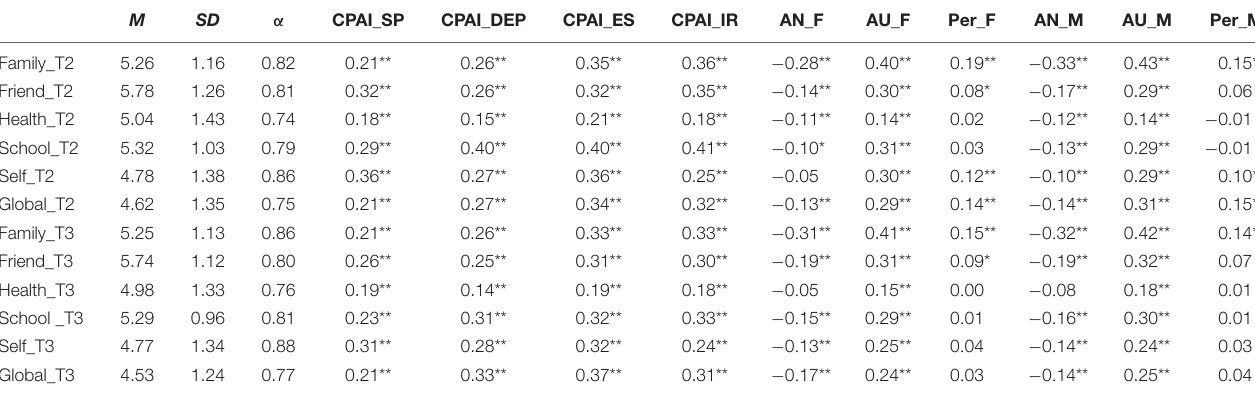
TABLE 2 | Descriptive statistics of life satisfaction at Time 2 and Time 3 and their zero-order correlations with personality and parenting styles.